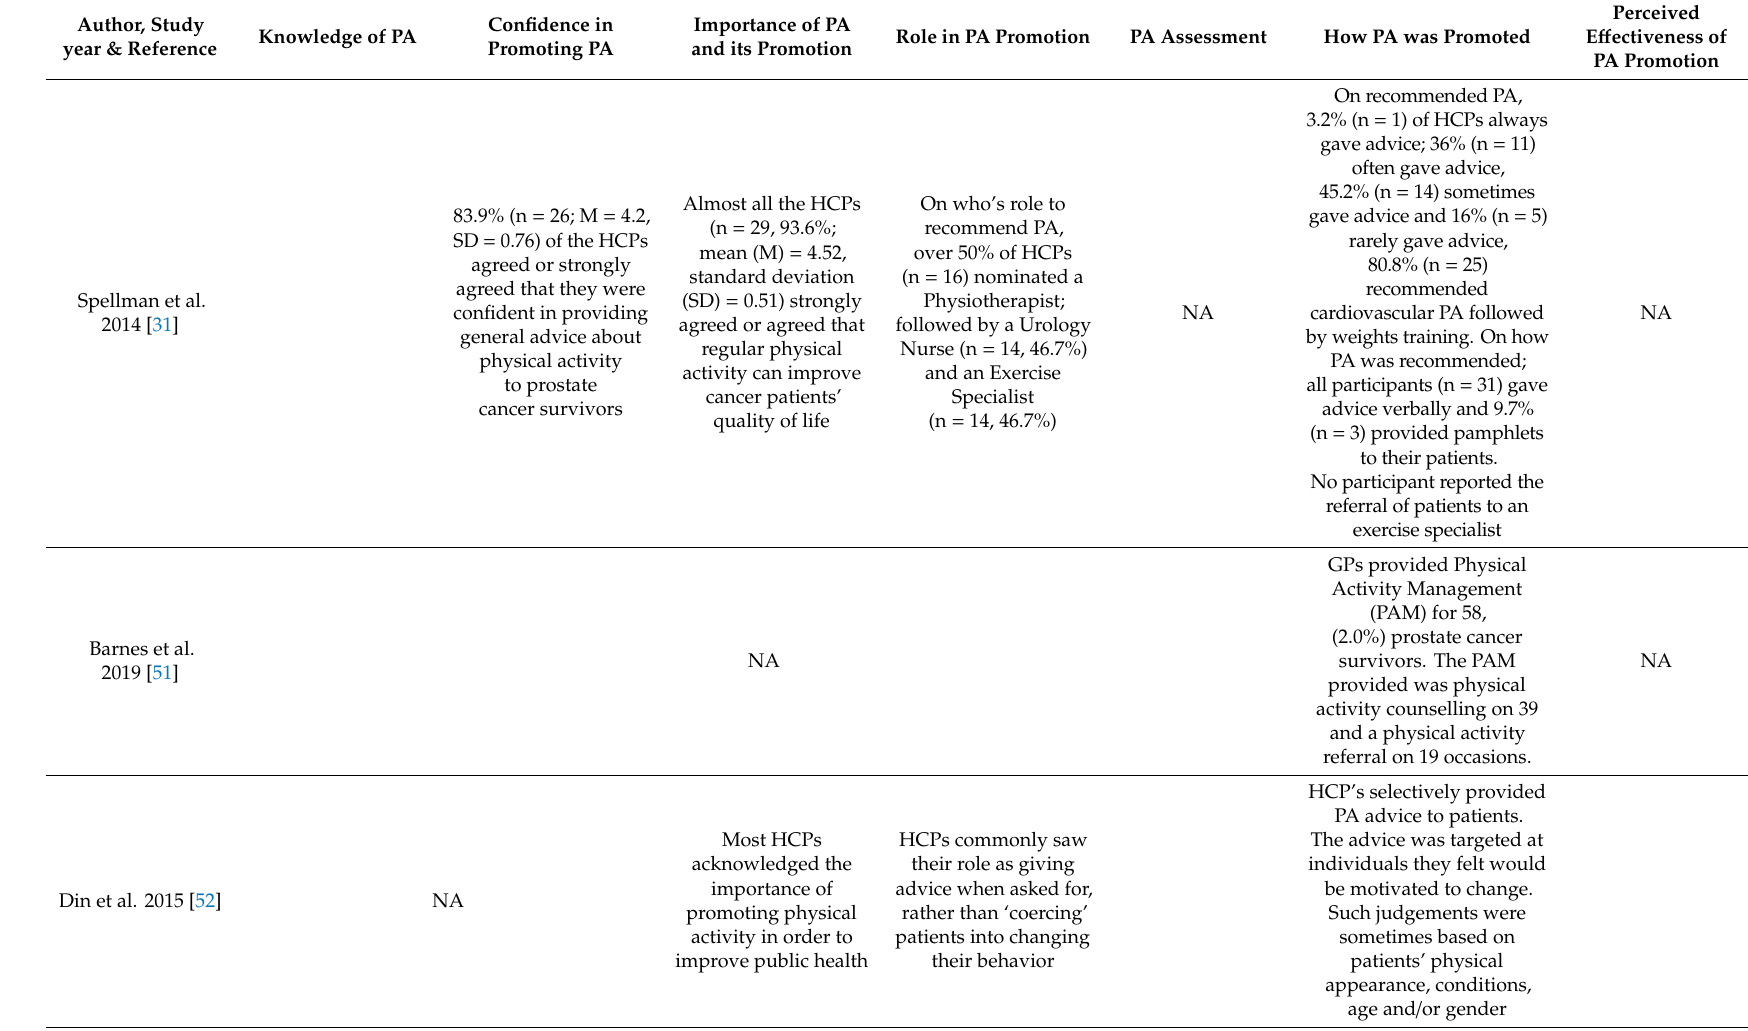
Table 2. Participants’ perceptions about physical activity (PA) knowledge, confidence, importance, role assessment, recommendation, and e ff